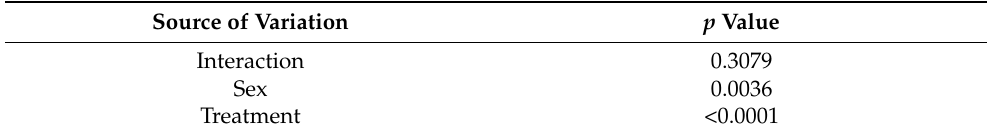
Table 3. Statistical table of the individual effects and interactions of rat sex and treatment on cardiac GSH+GSSG content.